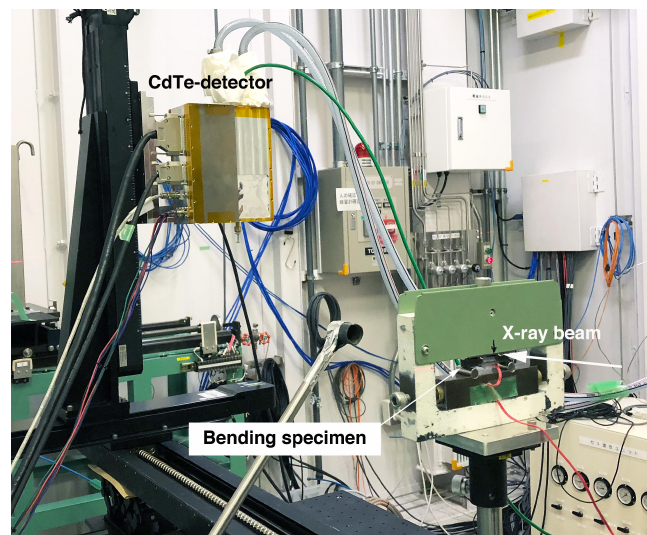
Figure 3. Experiment on beamline BL14B1 at SPring-8, Hyogo, Japan. The synchrotron white X-ray beam transmits the 4-point-bending specimen from the right side. The diffraction patterns are measured at locations P 1 and P 2 by moving the CdTe pixel detector through the